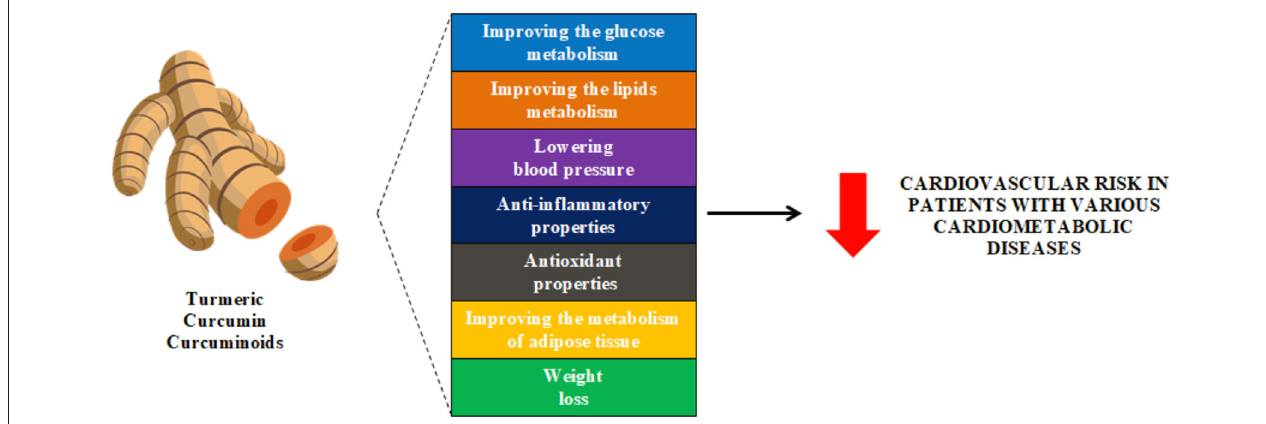
FIGURE 2 | Effect of curcumin on cardiovascular